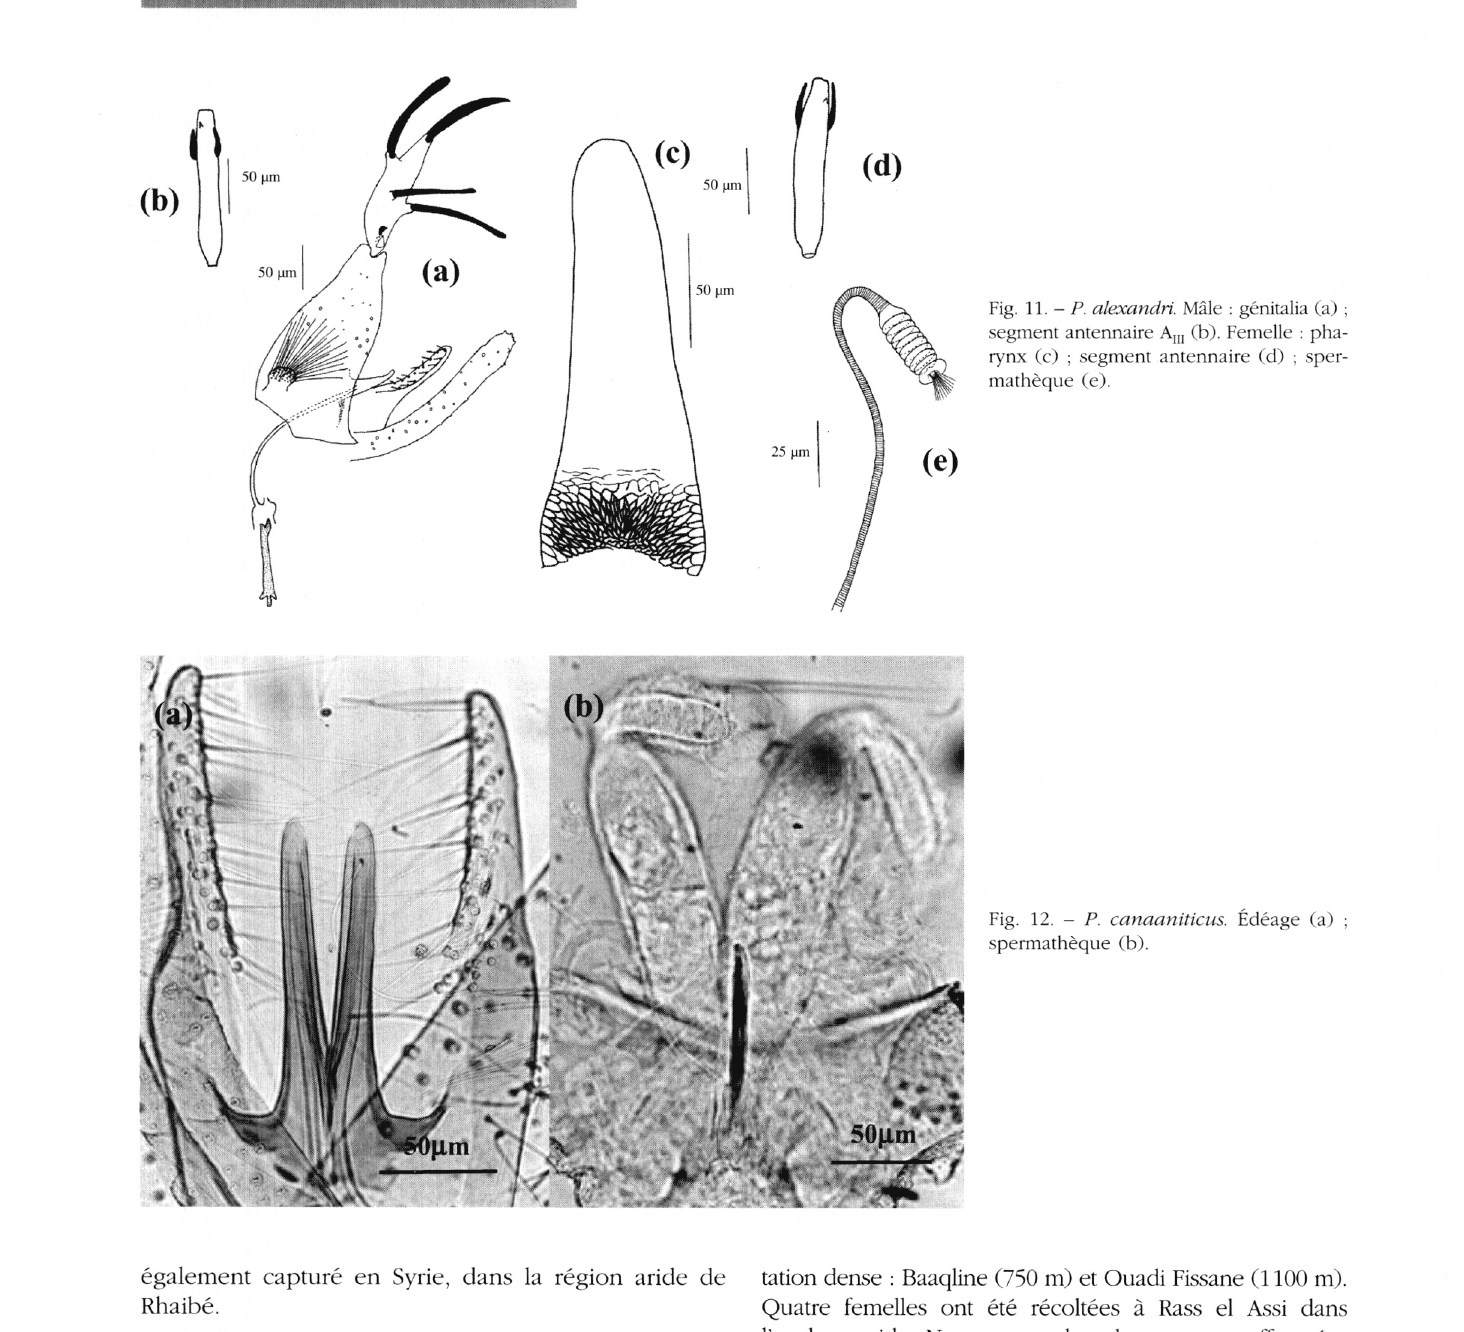
tation dense : Baaqline (750 m) et Ouadi Fissane (1100 m). Quatre femelles ont été récoltées à Rass el Assi dans l’enclave aride. Notons que dans les captures effectuées en milieu cavernicole (Wadi Jihanam), cette espèce est dominante et représentée essentiellement par des mâles.